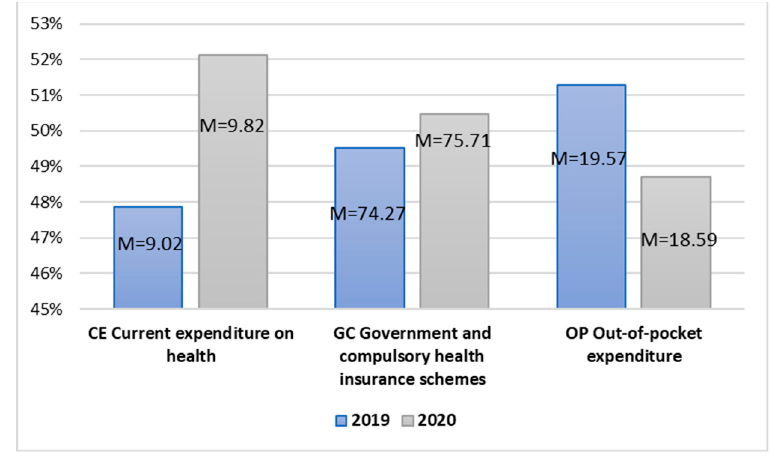
Figure 2. Independent sample mean values in the area of healthcare financing.